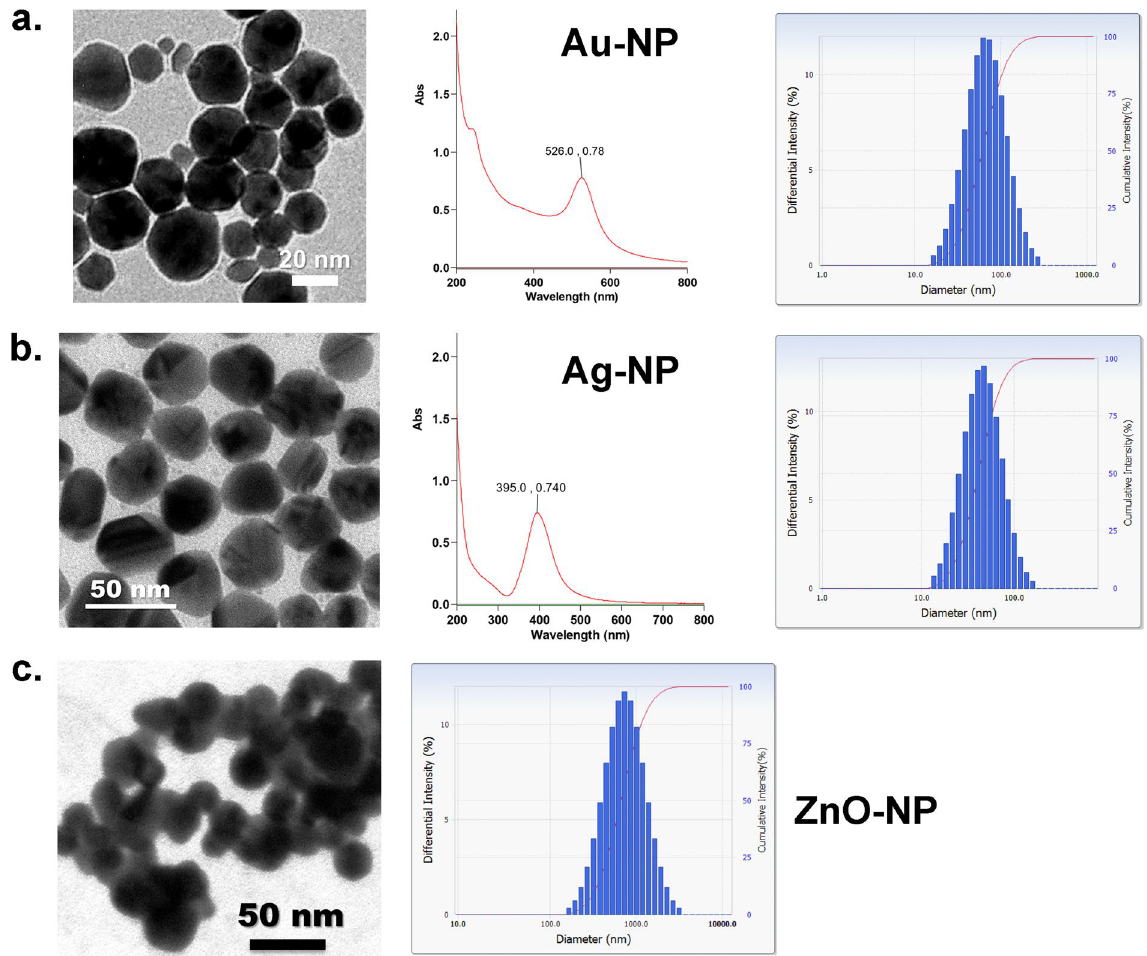
Figure 1. Transmission electron microscopy (TEM) images, UV–vis spectra and dynamic light scattering (DLS) analyses of metal nanoparticles. ( a ) Au-NP, ( b ) Ag-NP, and ( c )